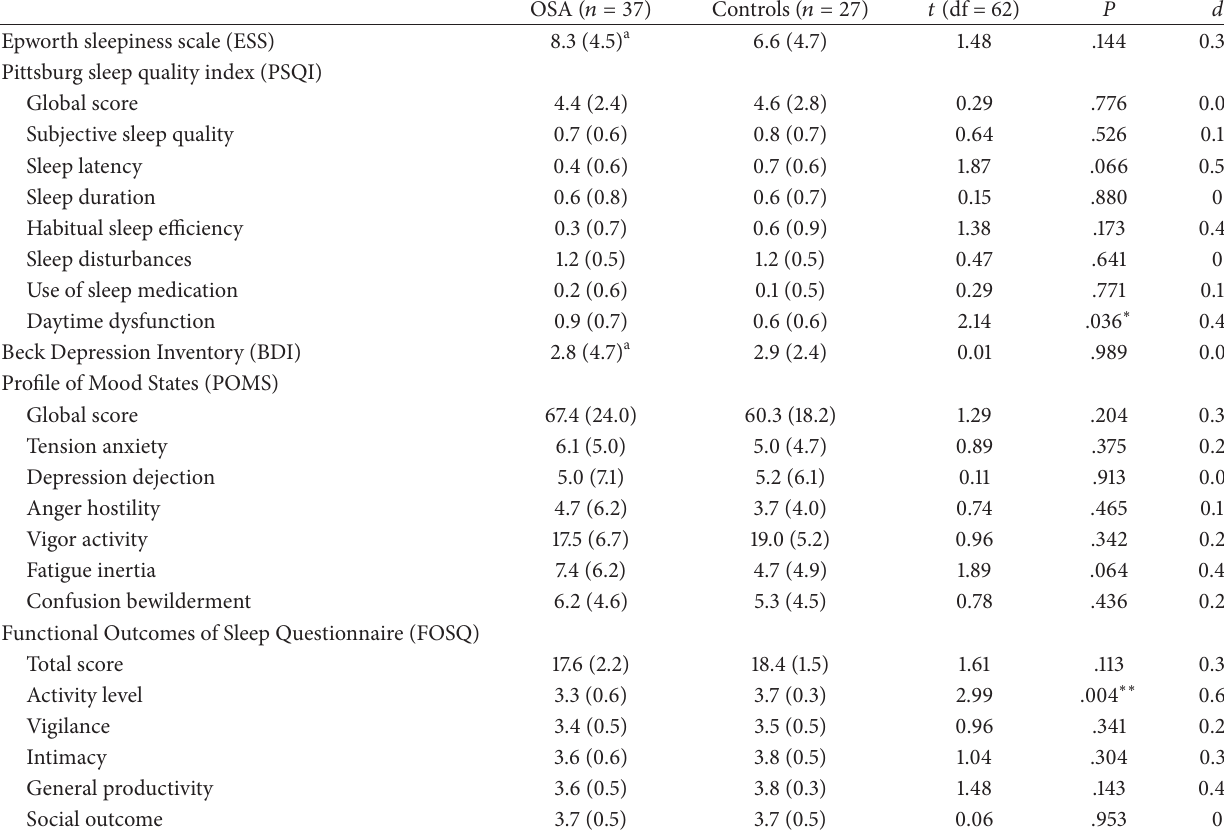
Table 2: Comparison between the OSA group treated with CPAP and the control group in sleep and mood